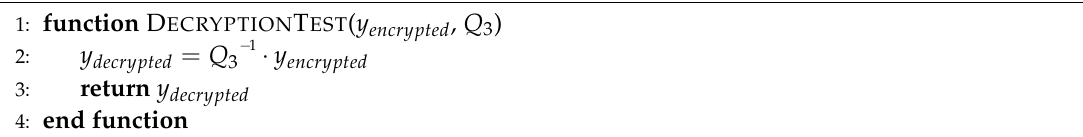
Algorithm 4 Decryption of Test